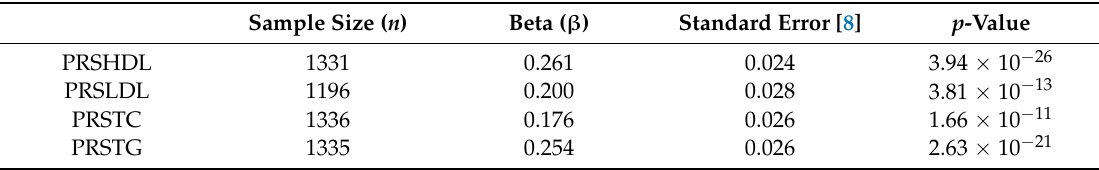
Table 4. Associations of different PRS ( p -value < 5 × 10 − 5 ) for lipid cardiovascular risk factors with measured lipid levels in the combined sample (55–106